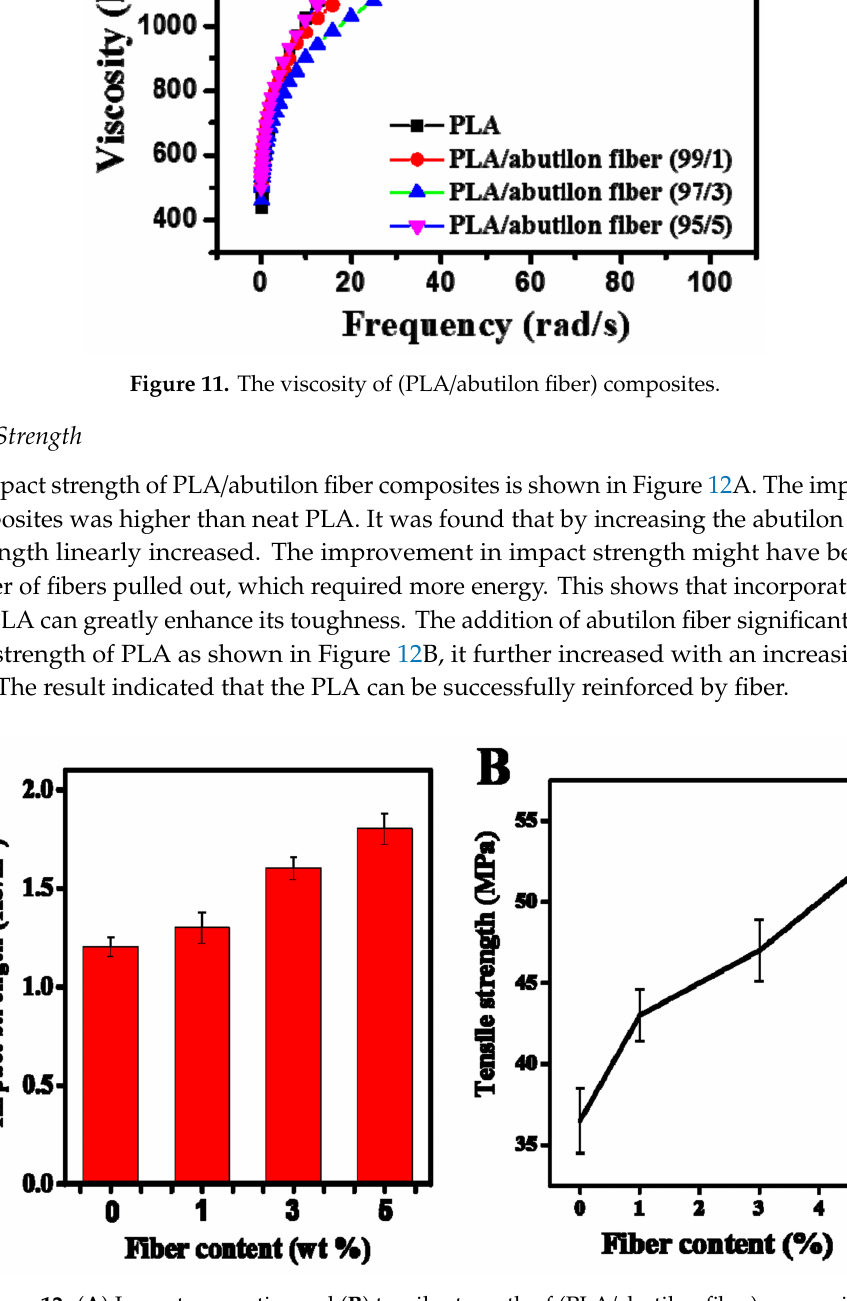
Figure 12. ( A ) Impact properties and ( B ) tensile strength of (PLA / abutilon fiber)